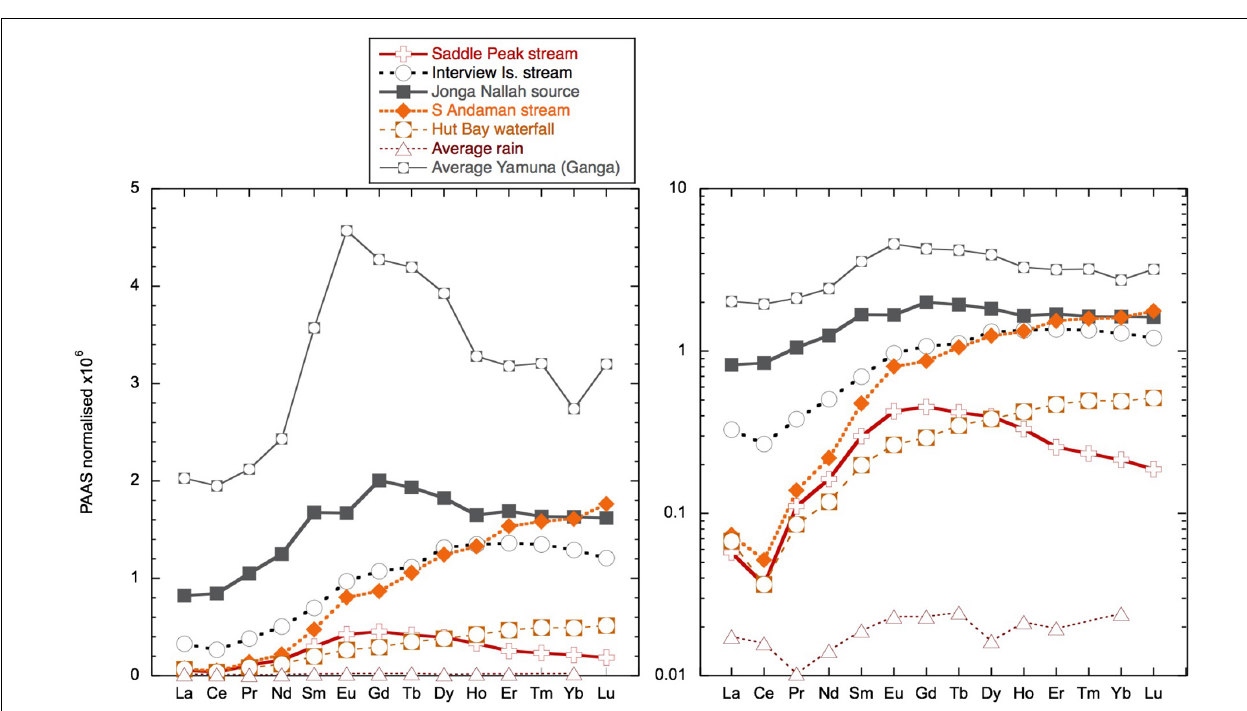
FIGURE 5 | Shale (PAAS; Nance and Taylor, 1976) normalized rare earth element (REE) patterns for freshwater samples including the Ganges tributary Yamuna from Rengarajan and Sarin (2004) and the average of the three rain samples. The two panels are the same data but plotted on log and linear scales. For the rain samples, Tm and Lu were below detection